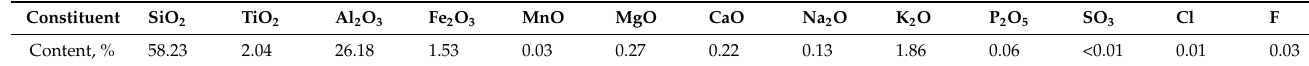
Table 1. Chemical composition of raw clay determined by XRF method (wt %).